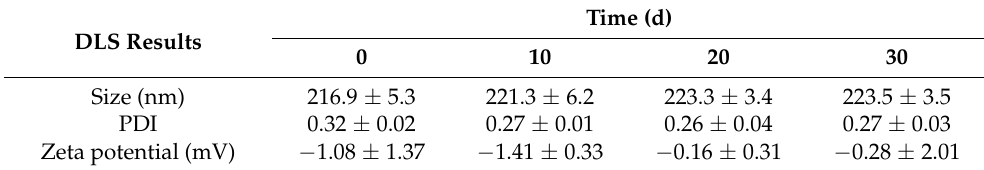
Table 1. Summary of particle size and zeta potential for NRG-NSps after storing at 4 ◦ C for one